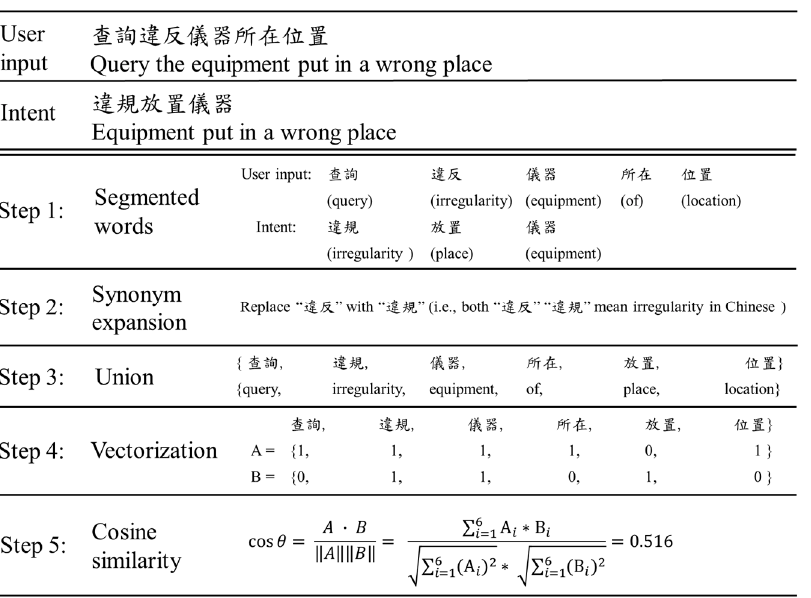
Figure 4. An example of cosine similarity.